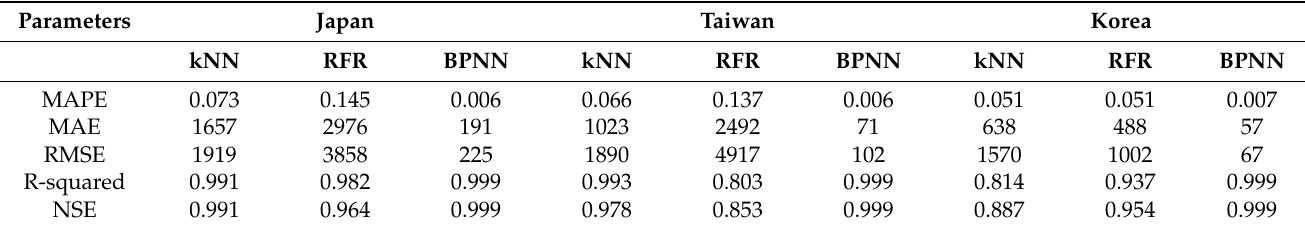
Figure 4. Vietnam labor immigration prediction for ( a ) Japan, ( b ) Korea, and ( c ) Taiwan. ( a ) labor immigration prediction for Japan; ( b ) labor immigration prediction for Korea; ( c ) labor immigration prediction for Taiwan. Table 3. Accuracy parameters for labor immigration prediction.